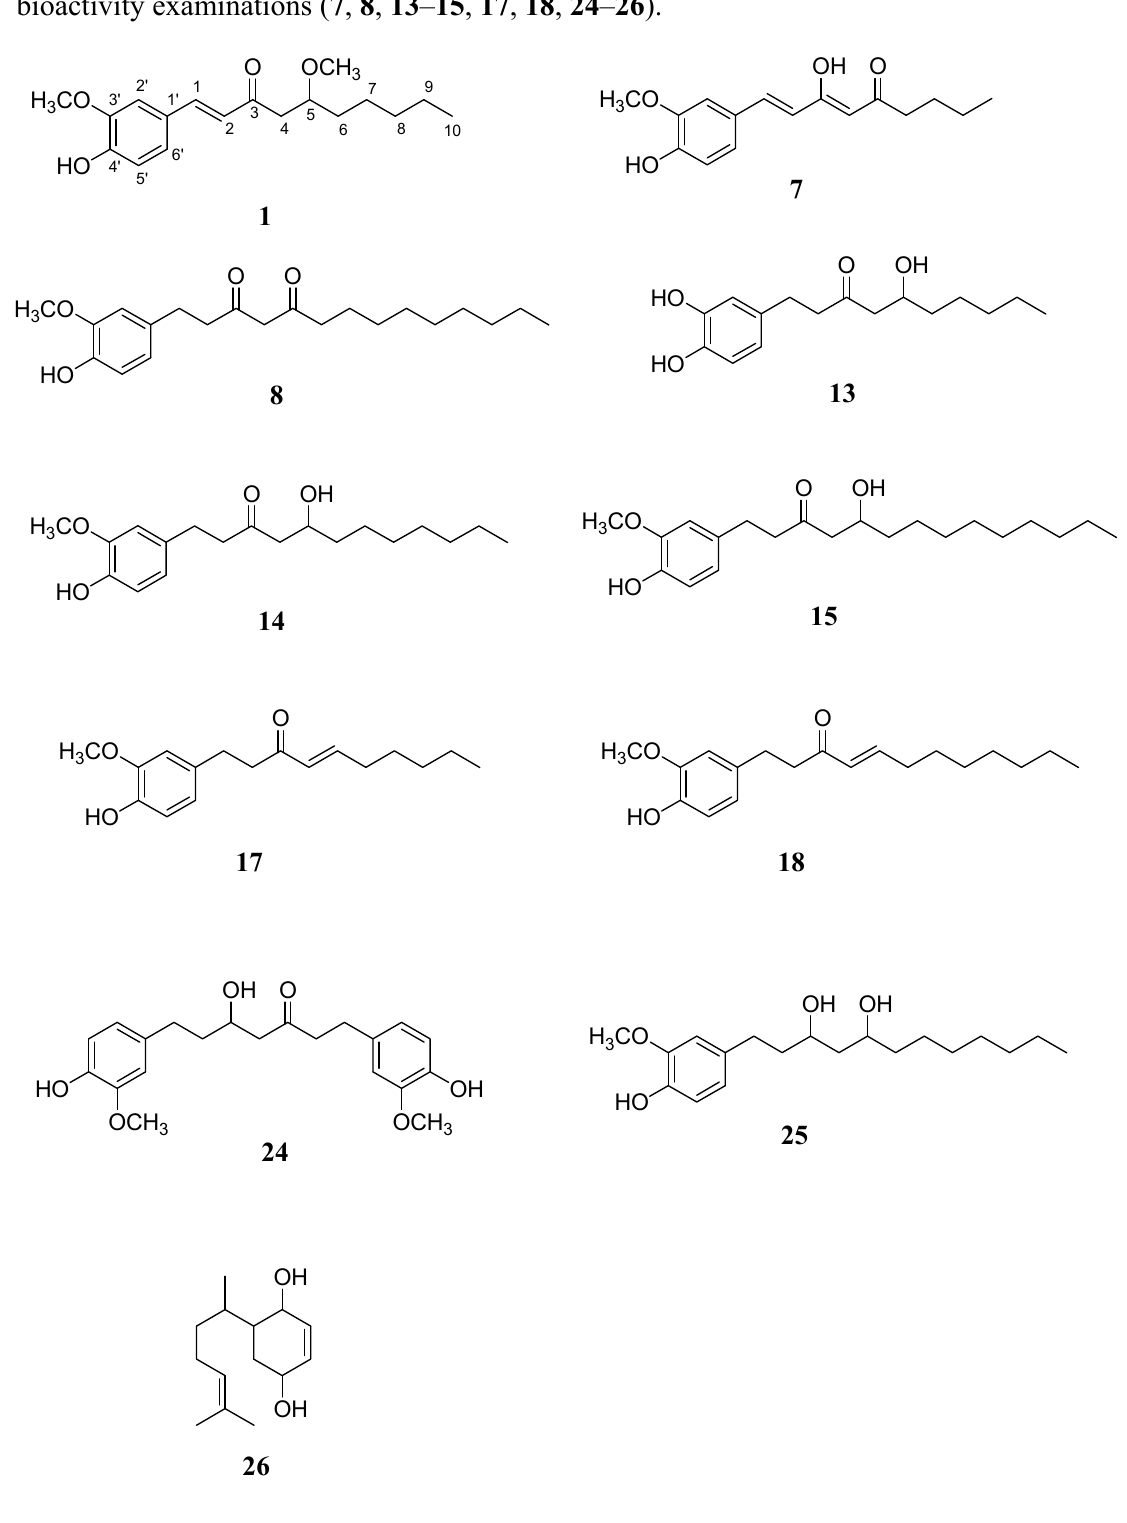
Figure 1. Structures of compound 1 and the purified constituents subjected into